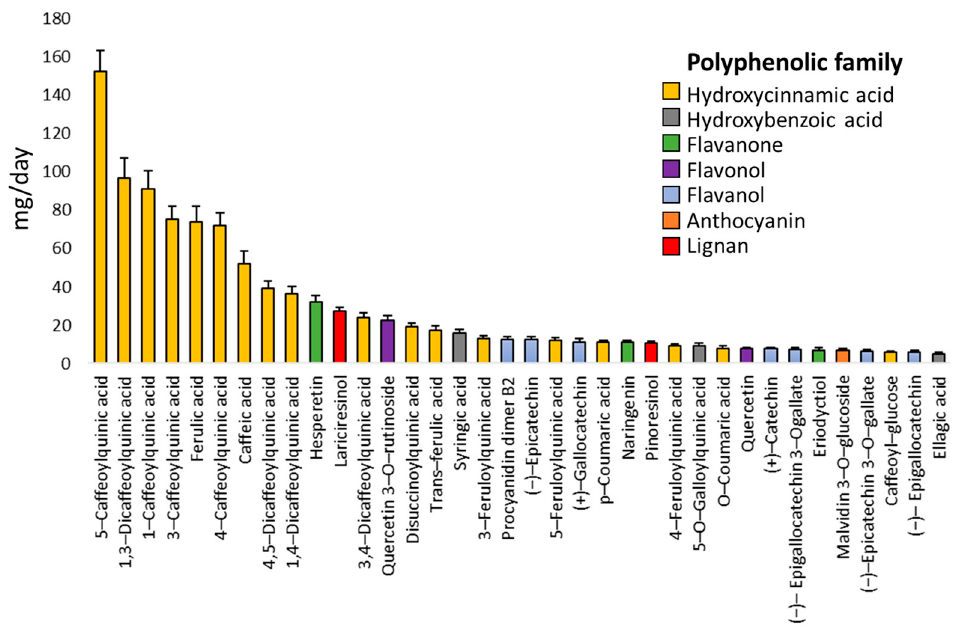
Figure 2. Daily dietary polyphenolic intake in postpartum women from Córdoba, Argentina ( n = 75), with data being expressed as mean and standard errors.